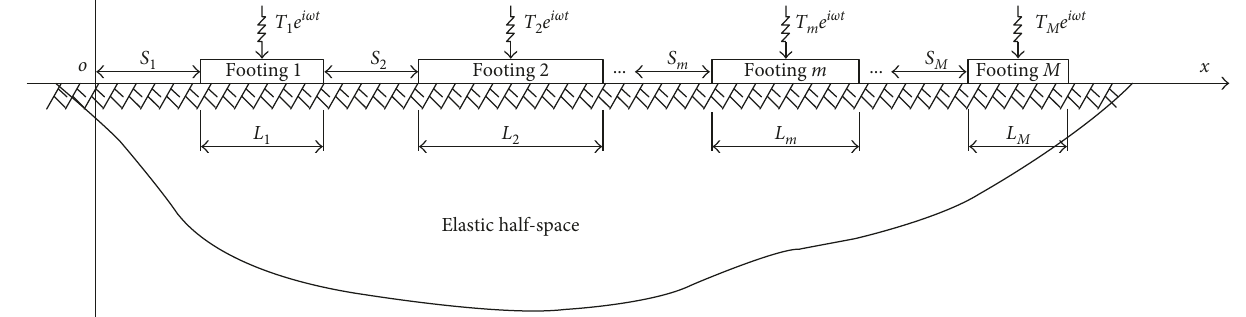
Figure 1: Strip footing group rested on an elastic half-space subjected to vertical harmonic excitations.